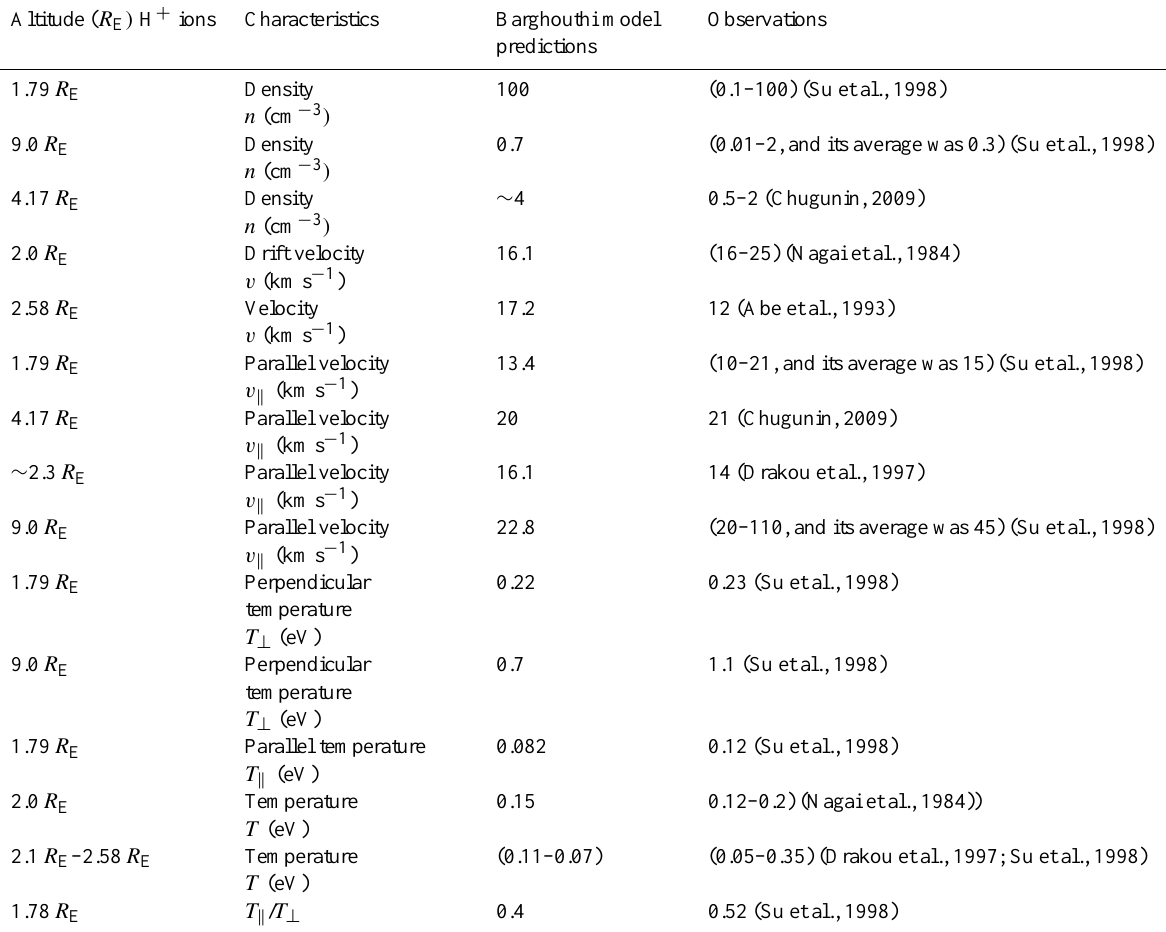
Table 1. Comparison between the observations and simulation results of Barghouthi model for H + ions. Please note, in observational studies they use the terms velocity, parallel velocity, and drift velocity. All these terms are the same in observational studies and correspond to drift velocity in simulation